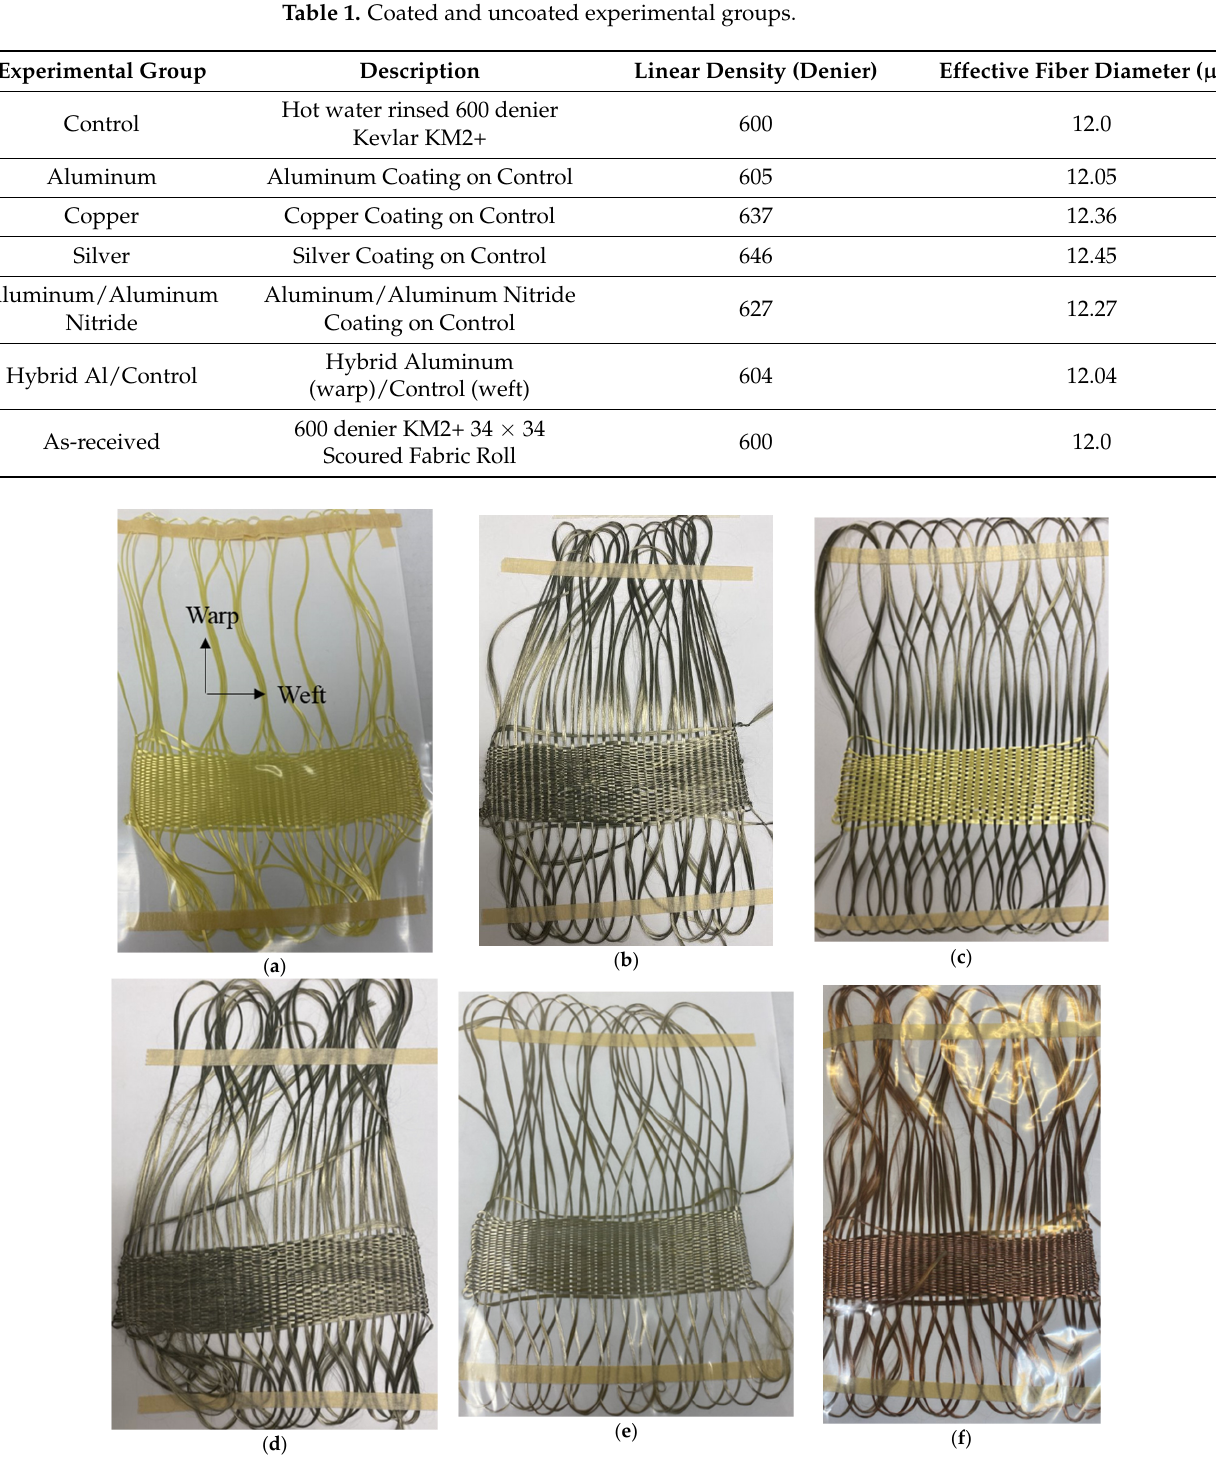
Figure 2. Hand ‐ woven fabric swatches ( a ) Control ( b ) Aluminum ( c ) Hybrid Al/Control ( d )Alumi ‐ num/Aluminum Nitride ( e ) Silver ( f )